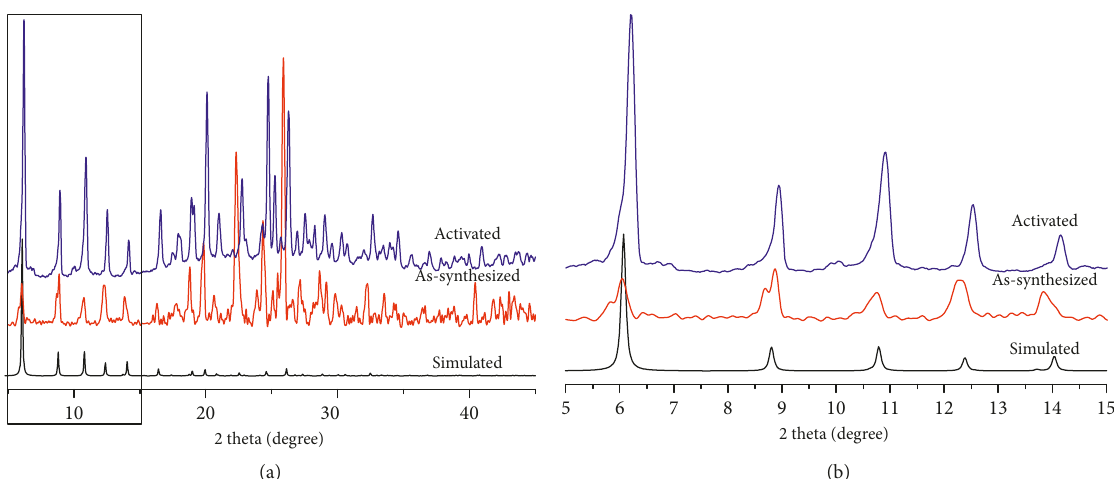
Figure 2: (a) The powder XRD patterns of compound 1 under different conditions. (b) The amplification of the 2theta in the range of 5–15 degrees.